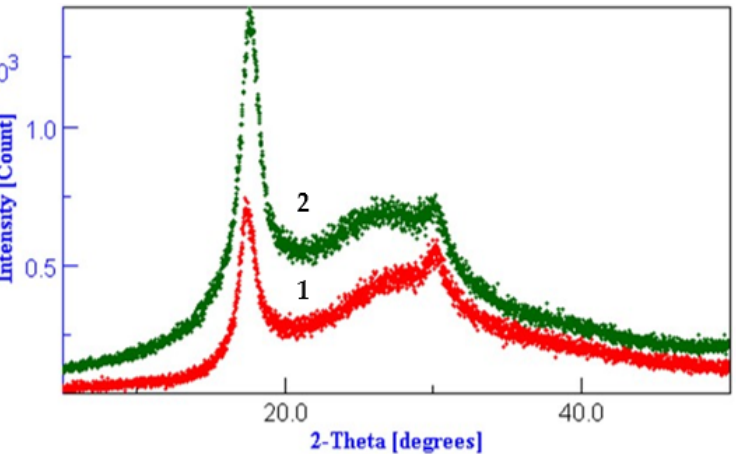
Figure 6. Diffractograms of Melana treated at 120 ◦ C for 30 min with excess of reagents: ( 1 ) control sample, and ( 2 ) sample V1 with KOH plus iodine.